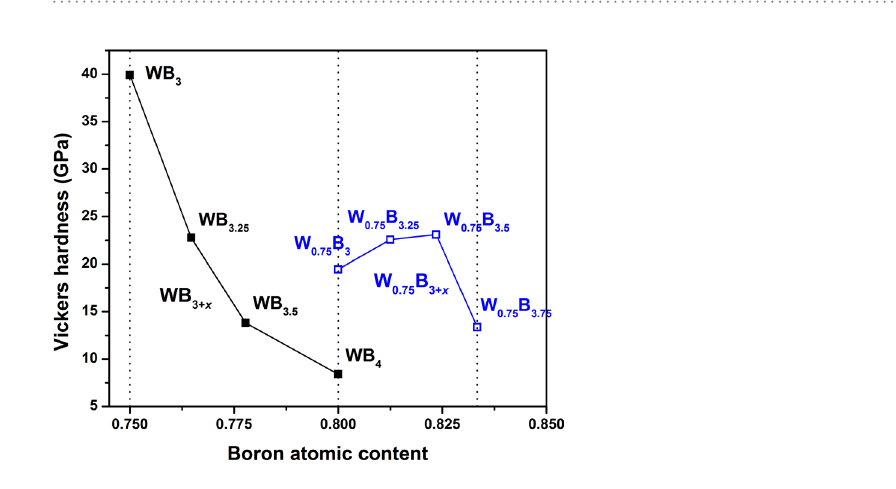
Figure 4. Vickers hardnesses calculated for the most stable structures at a given boron atomic content. The filled and open squares correspond to WB 3 + x and W 0.75 B 3 + x compounds, respectively. The structures of WB 3 + x are shown in Fig. 1a and c, and Fig. 3a and b, whereas the structures of W 0.75 B 3 + x are shown in Fig.